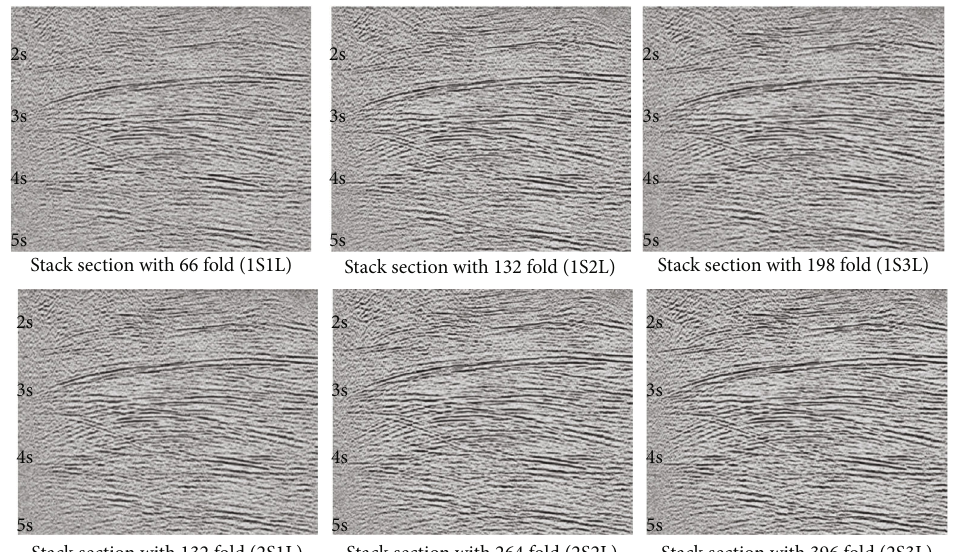
Figure 8: Stack sections with di ff erent